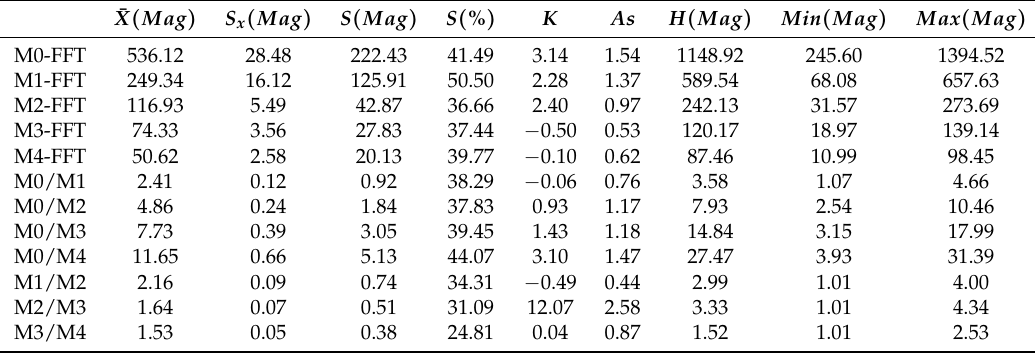
Table A2. Statistical descriptive measures of the magnitude data of the standard group of A. fraterculus .